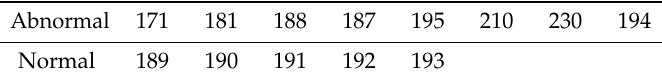
Table 7. Training dataset (Unit of measure: millimeter).